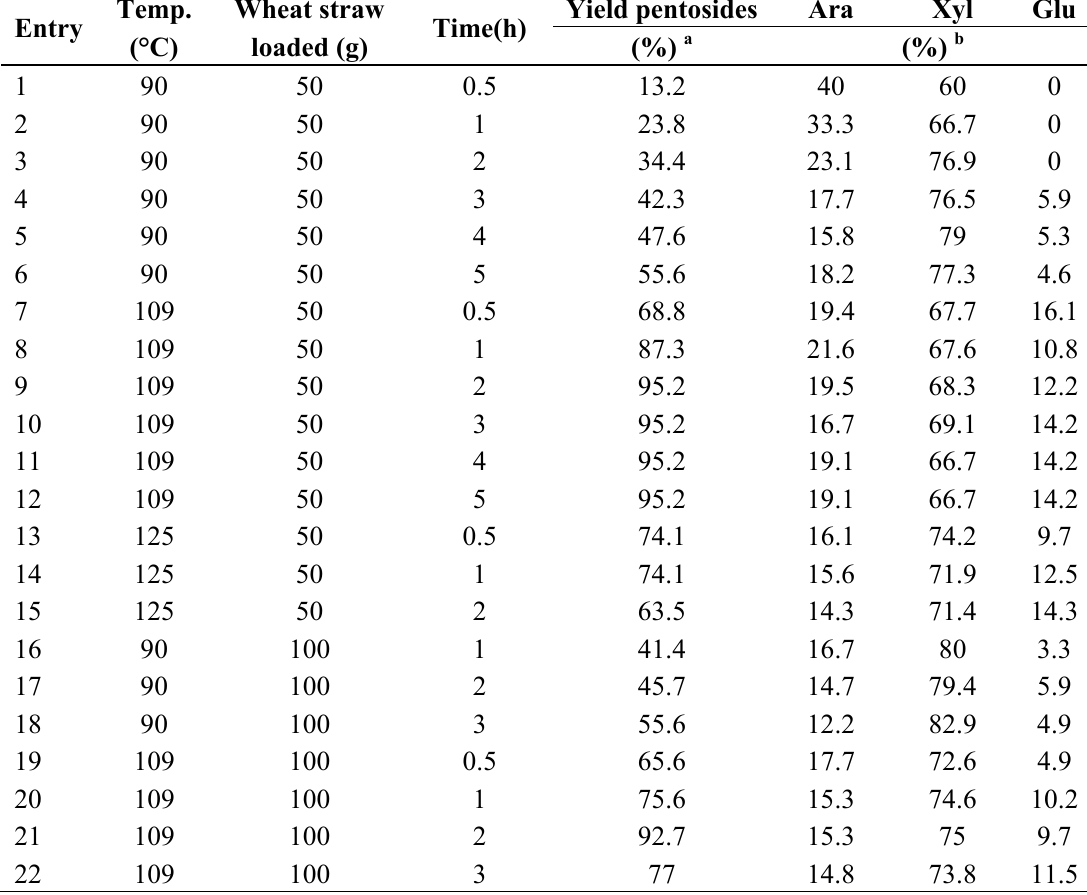
Table 1. Pretreatment of wheat straw in sulphuric acid decanol